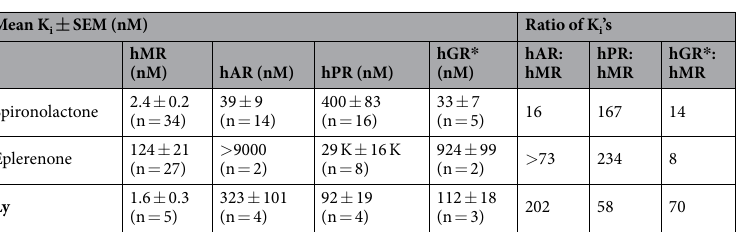
Mean K i ± SEM (nM)